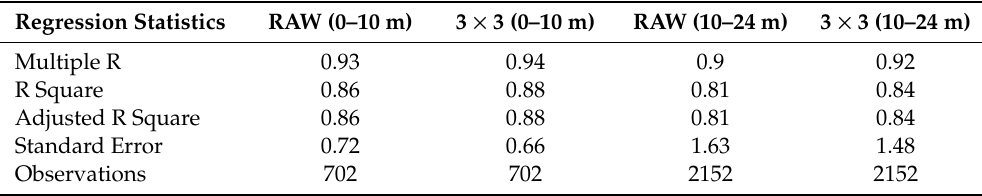
Table 3. The results from the multiple regressions using the training data on the RGB spectral bands of the image of 11 July 2017 in the depth zones 0–10 m and 10–25